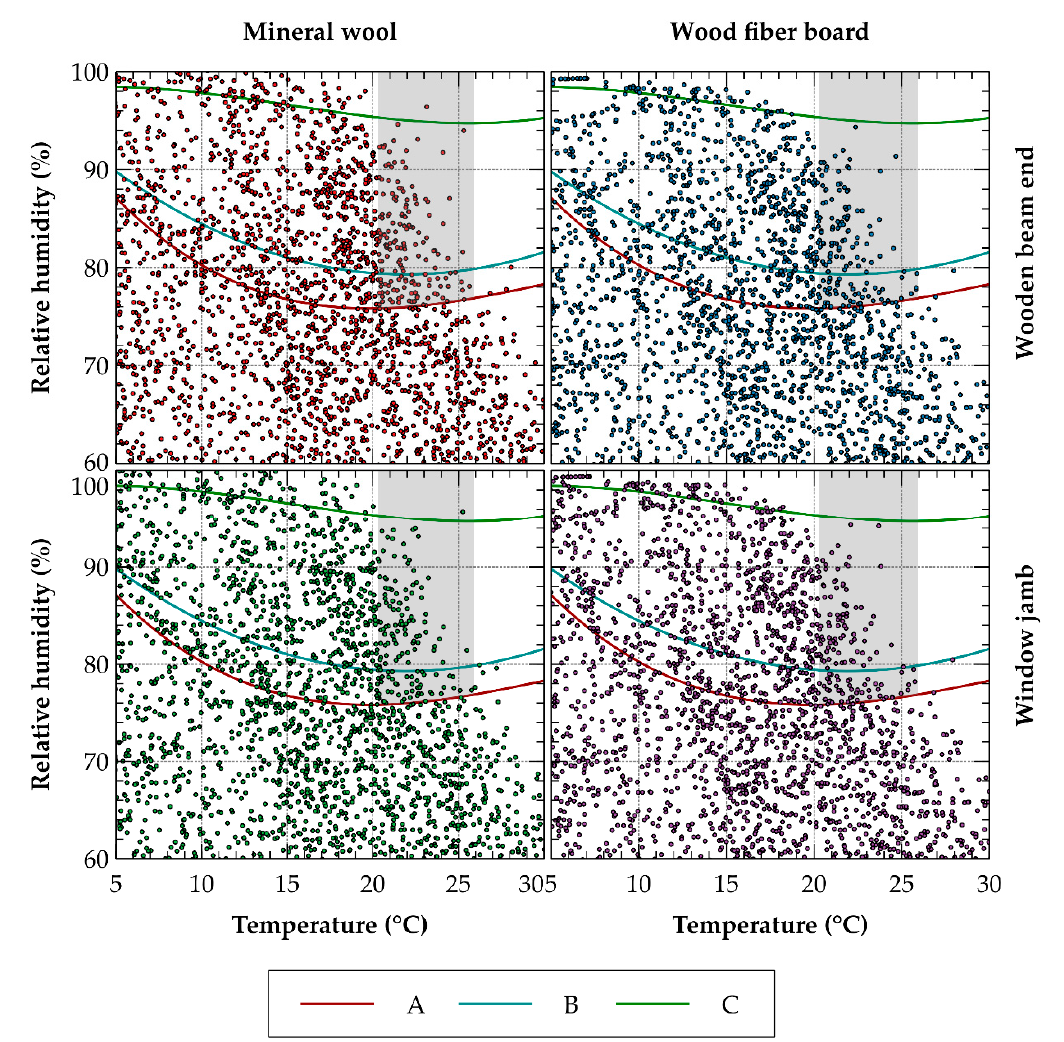
Figure 14. Assessment of hygrothermal conditions favorable for biofilms growth. All the variations investigated are presented. Left column—mineral wool; right column—wood fiber board; 1st row—wooden beam end; 2nd row—window jamb. The lines A, B, and C mark various growth-demanding nature of biofilms, as described in Section 3. The dots show the hourly values of relative humidity and temperature obtained using computational modeling described in Section 4.